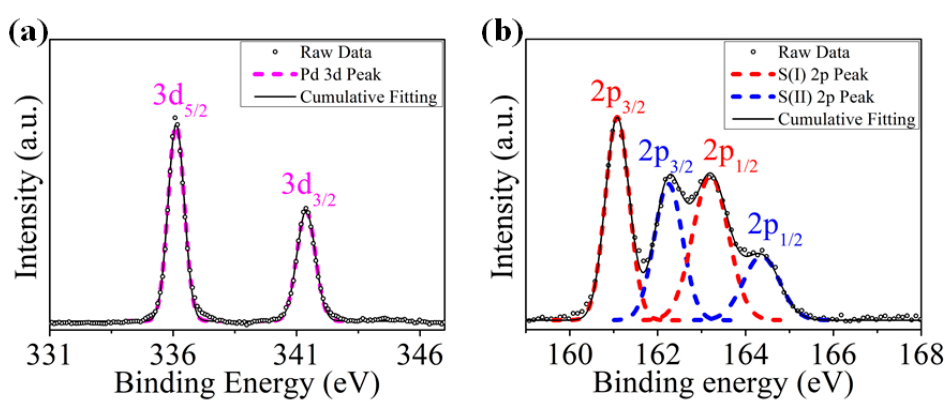
Figure 4. PdS 2 XPS spectrum ranging from ( a ) Pd 3d and ( b ) S 2p regions.code.